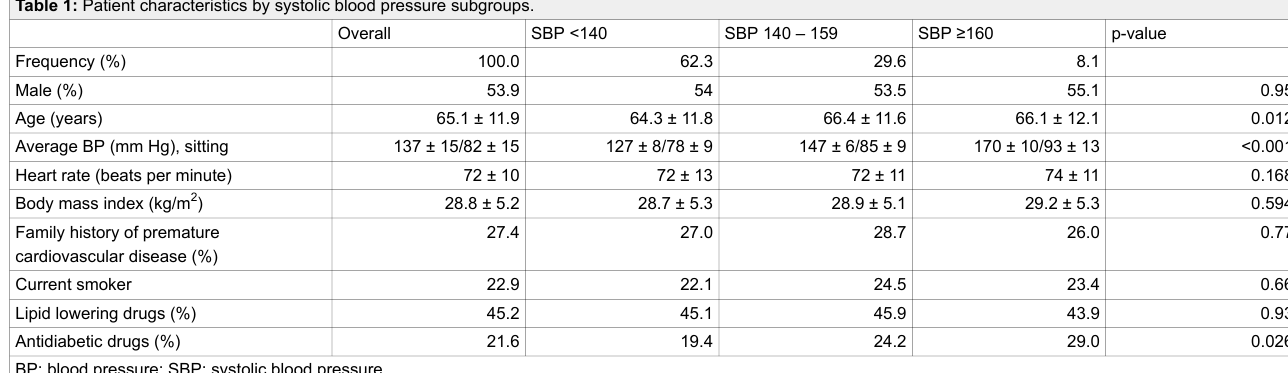
Table 1: Patient characteristics by systolic blood pressure